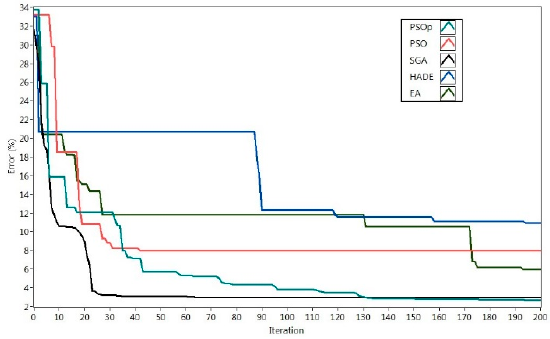
Figure 6. Optimization algorithms behaviours (global best result).